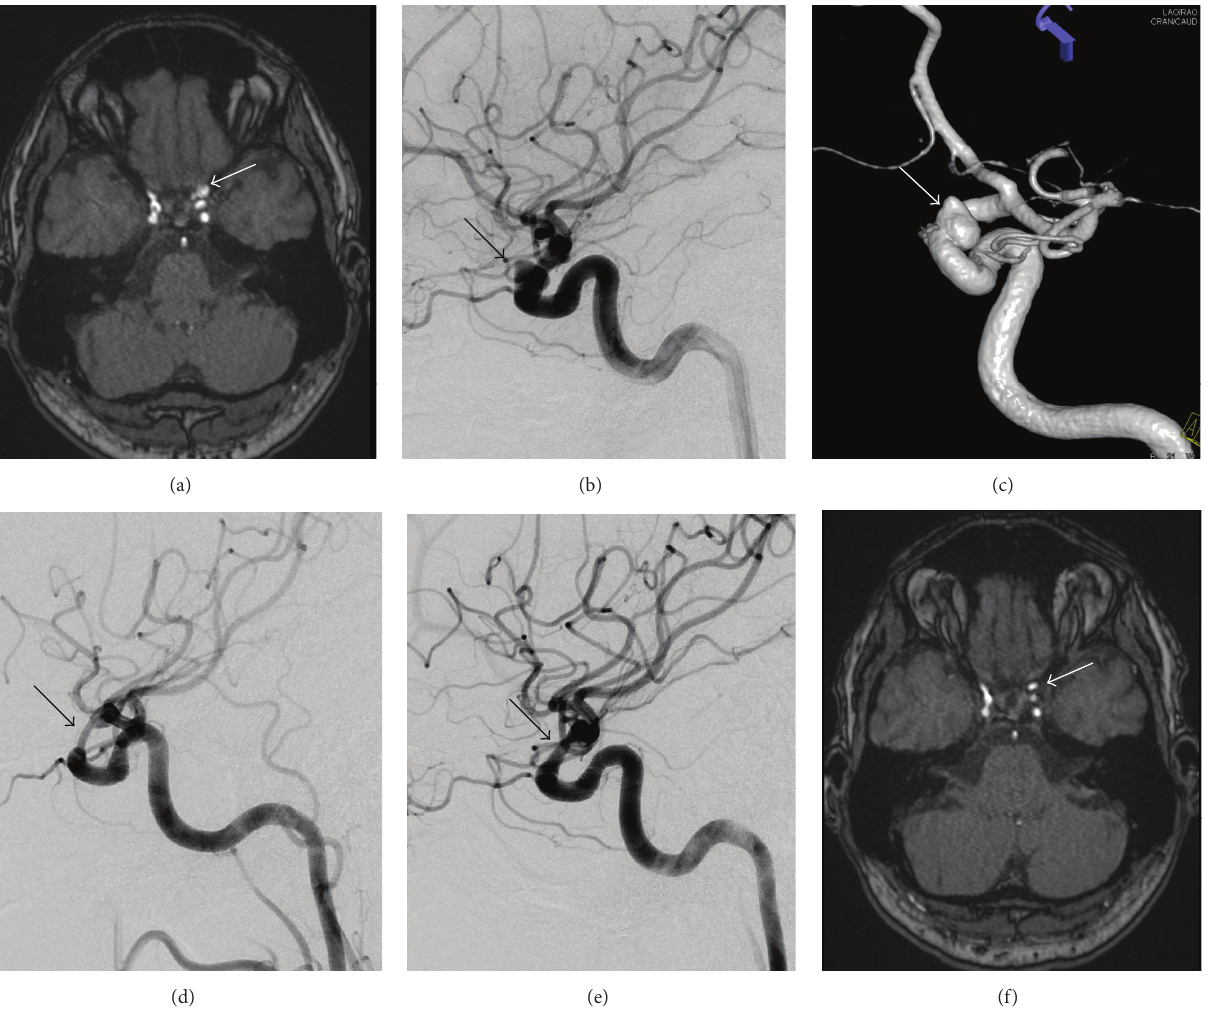
Figure 2: Postinterventional stenosis (patient number 25). 44-year-old man with incidental finding of aneurysm in the left carotid artery on MR angiography (a), confirmed by digital subtraction angiography (b, c). After flow diverter treatment, nonsymptomatic stenosis was detected and was stable in 6 months’ follow-up (d); stenosis improved at 12 months’ follow-up (e) and further noninvasive examinations.